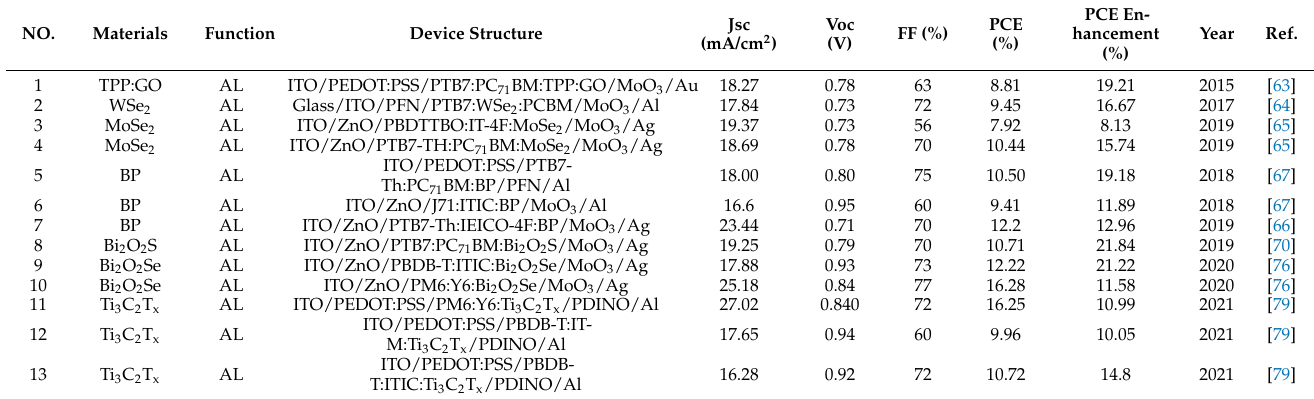
Table 2. 2D layer materials incorporated into the active layer of the OSC with PCE over 7%.